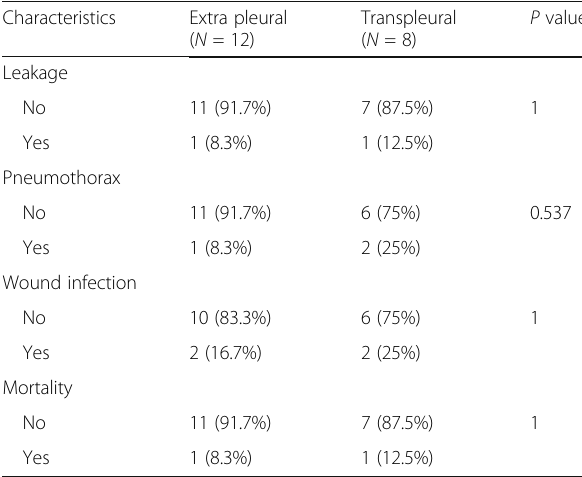
Table 4 Comparison between the studied groups regarding complications